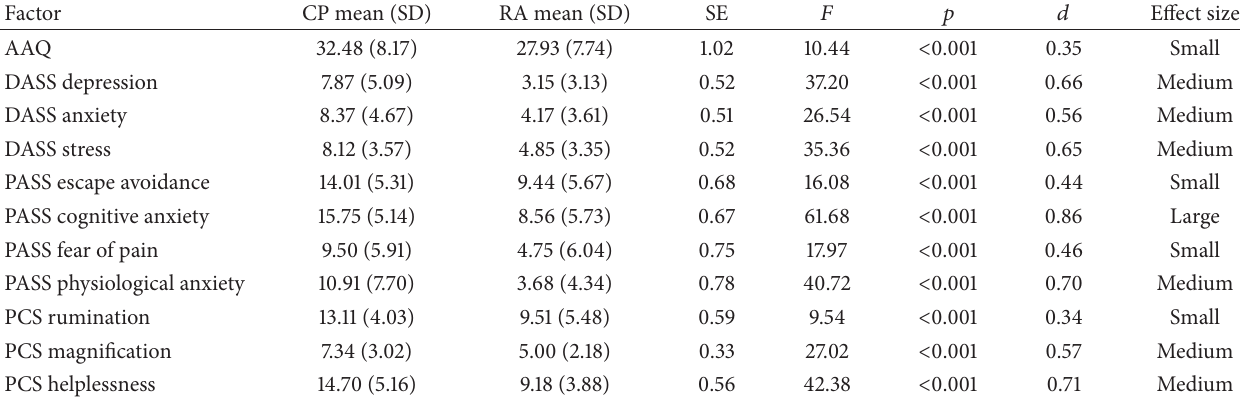
Table 2: Pairwise comparison psychological factors by group after controlling for average pain